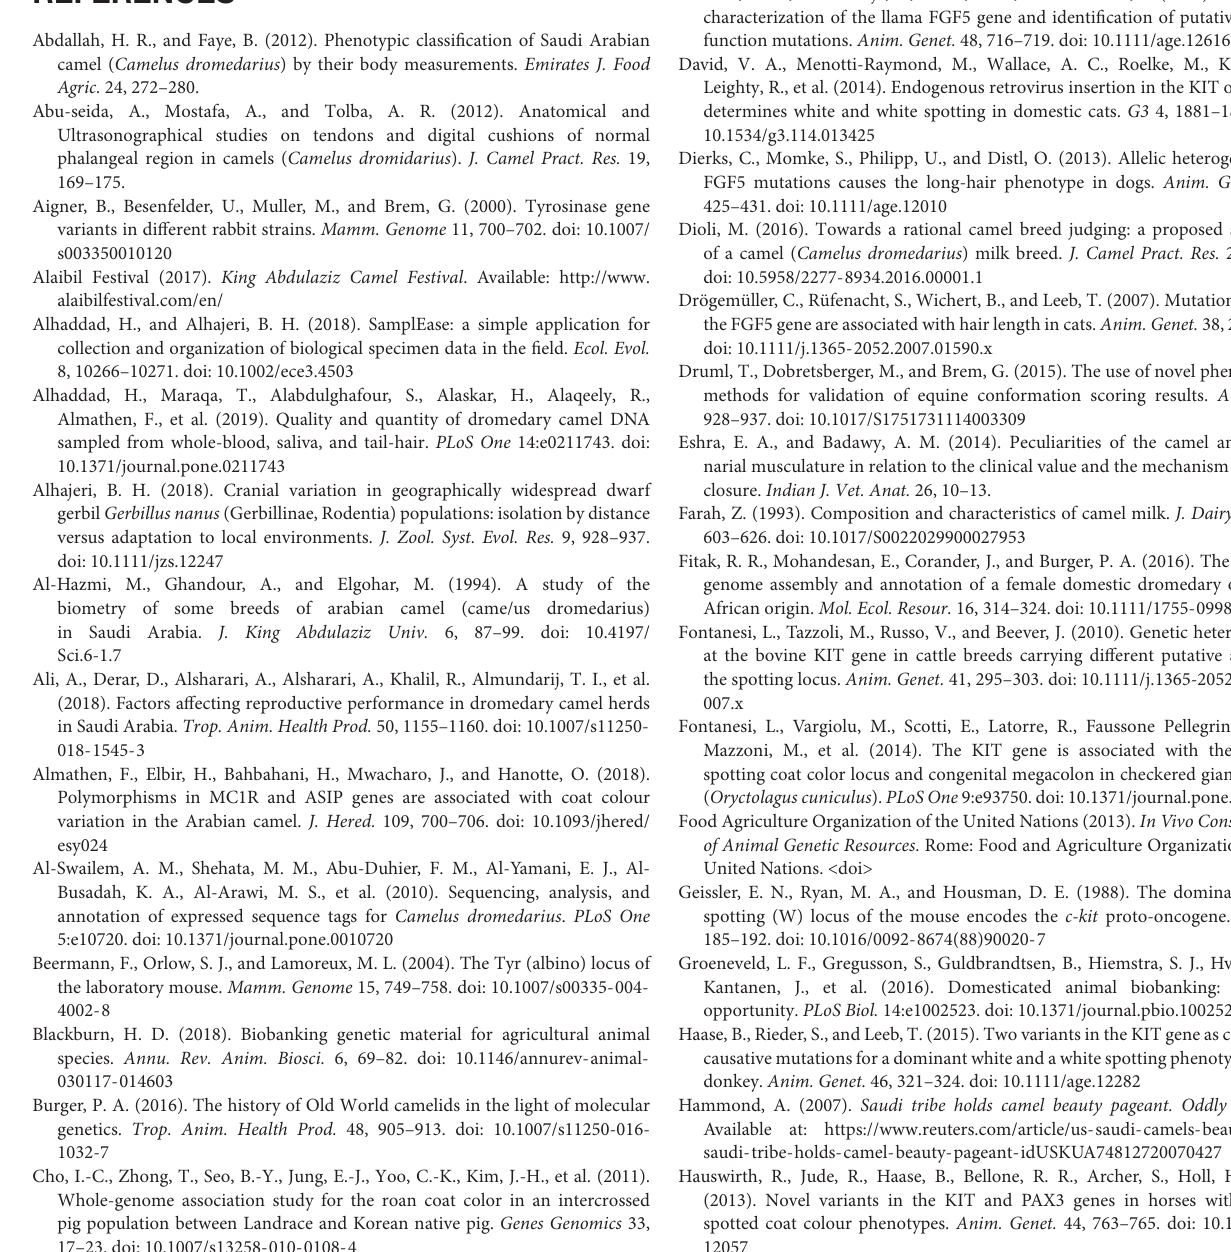
TABLE S1 | Camel terminology used to describe female camel age classes. Age terms were translated from original Arabic terms and the Arabic pronunciation is shown in italics. Similar names are given to male camels with slight differences related to gender changes to original terms in Arabic.